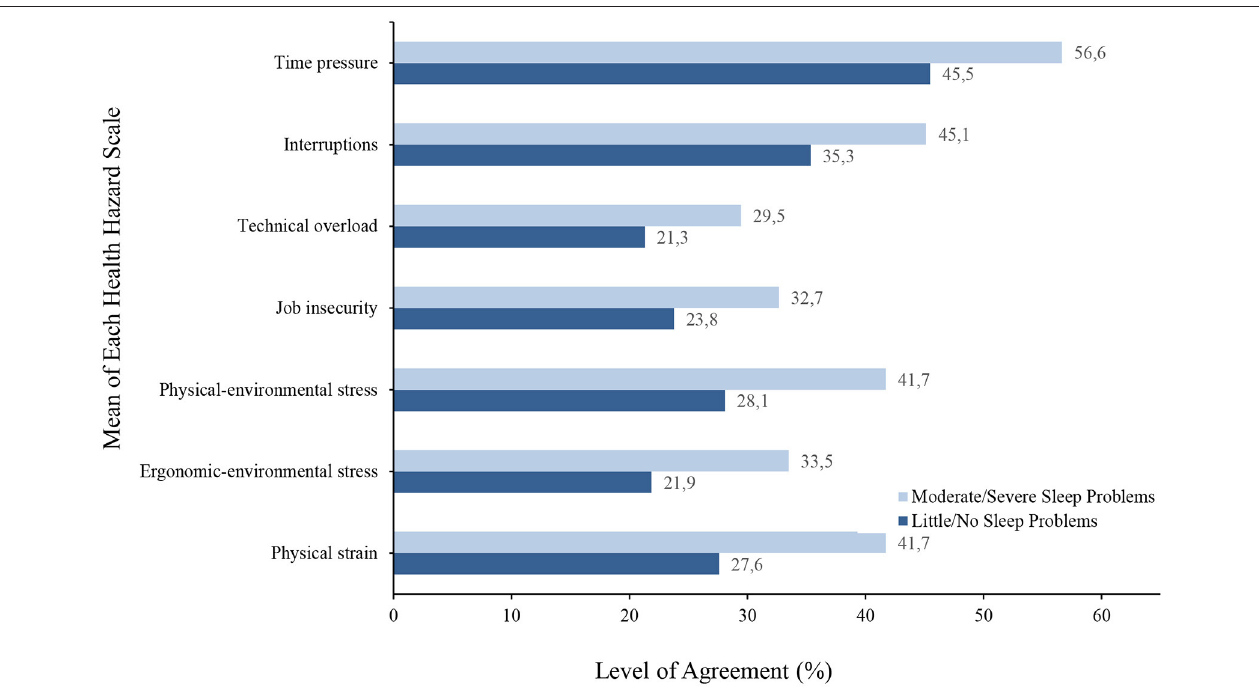
FIGURE 4 | A bar graph to show the mean level of agreement for each health hazard (scales that refer to the negative effects on our well-being) in both good and poor